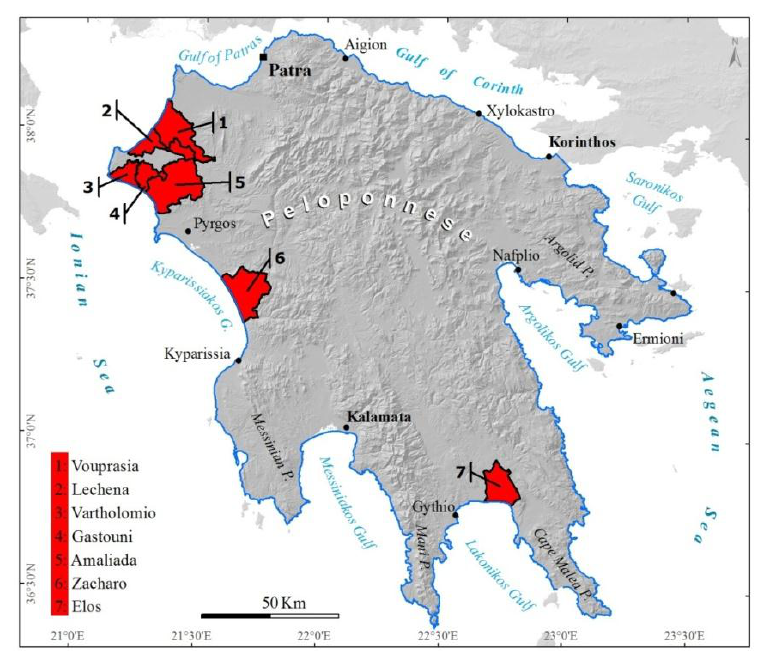
Figure 4. Location map of the seven more vulnerable (both physically and socially) municipal communities of the Peloponnese. These municipal communities have high or very high values of SVI while more than 80% of their coastal zone is also of high and very high physical vulnerability.